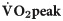
Correlations Between Plasma LECT2 Levels and BMI (A), Body Fat (B), WC (C), VFA (D), SFA (E), and V˙O2peak (F).LECT2 and SFA were log-transformed for analysis.